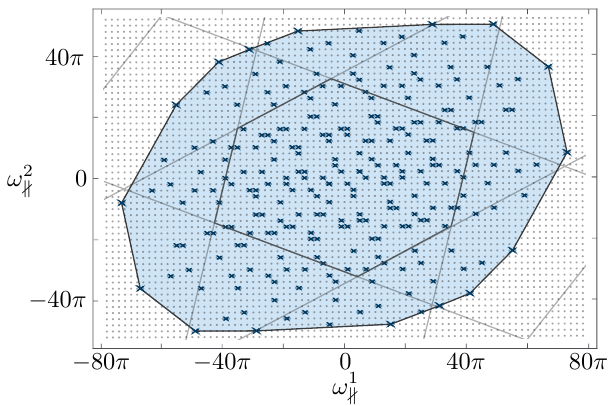
Figure 5 . Illustration of the ! -coordinates for every distinct tile on (cid:6), in an example where , P = N + 2 = 8. The central six-sided region denotes the area bounded by the simple su(cid:14)cient condition (2.29), while the full shaded region C contains all lattice sites whose P -cubes intersect the constraint surface. Blue crosses (large and small) denote the coordinates of centers of cubes which have a vertex that lies on